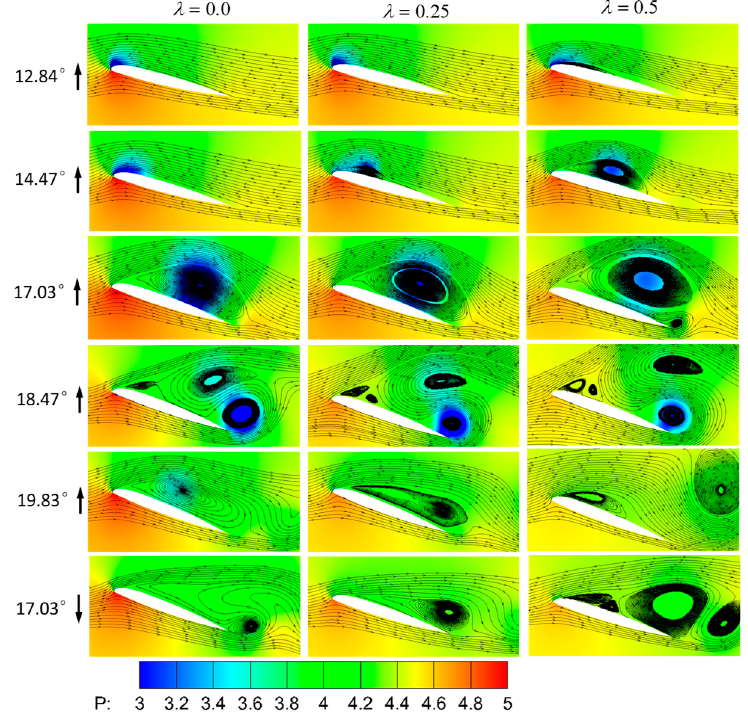
Figure 10. Comparisons of pressure contour and streamlines at different oscillating velocities (k = 0.075, α = 12.0 ◦ + 8.0 ◦ sin ( ω t + π ) ). Table 2. AoAs of leading edge vortex (LEV) and trailing edge vortex (TEV) formation. λ =